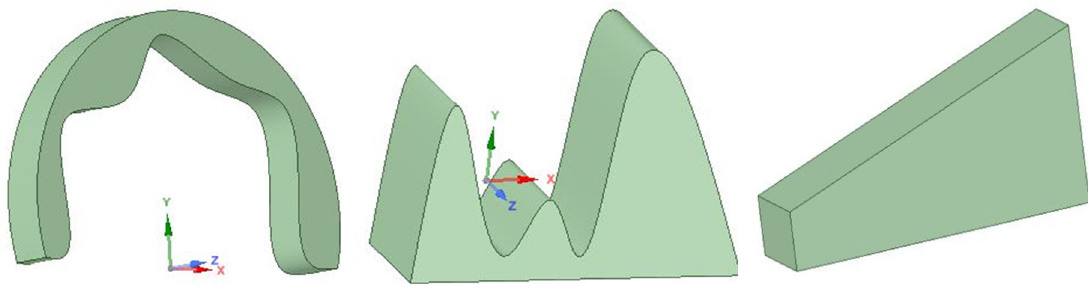
Figure 1. Three-dimensional models produced for thermal analysis.